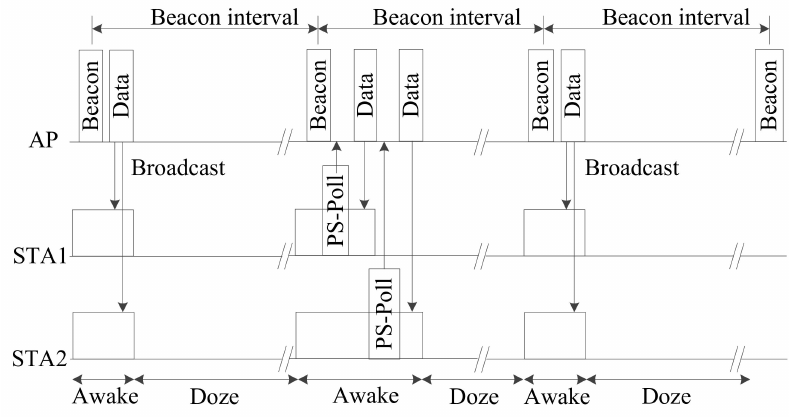
Figure 1. 802.11 legacy power-saving